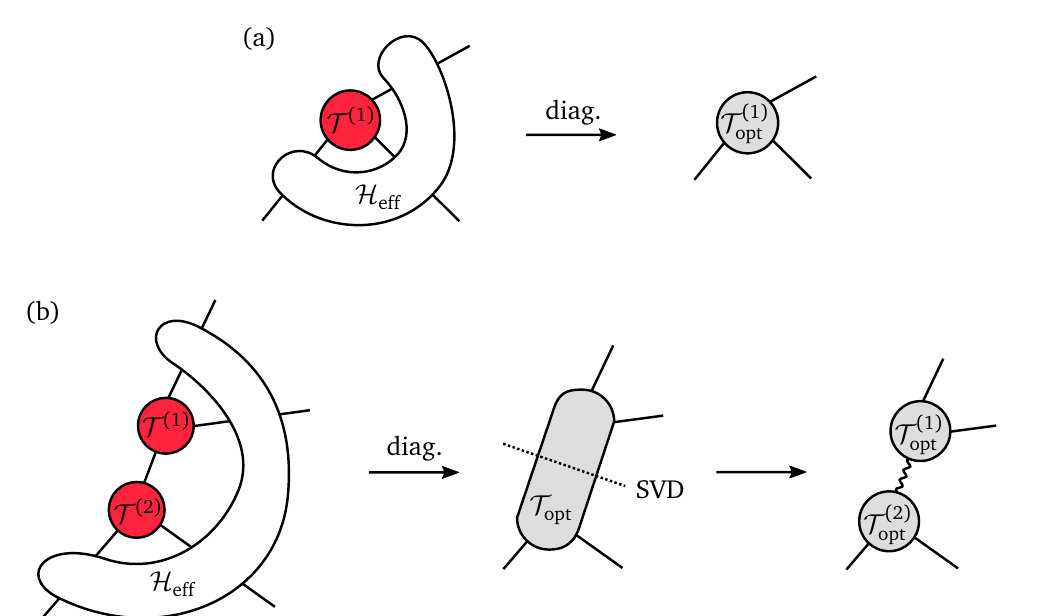
Figure 45: (a) Single-tensor update: the reduced diagonalization problem is formu- lated for one tensor. The optimized tensor is given by the eigenvector of H with eff the smallest eigenvalue. Note that link representations are preserved if H obeys eff some symmetry. (b) Double-tensor update: the reduced diagonalization problem is formulated for two tensors. The number of links of the optimized tensor is given by the number of links on which H acts. Link representations of these links are eff again preserved, in contrast to the one of the link which joins T ( 1 ) and T ( 2 ) : This link results from an SVD and can differ from the original link, if the SVD performs a non-trivial separation of the links of T . Note that if one of the two tensors is a opt two-link tensor, this link separation is trivial and the link created by the SVD will be the same as the external link of the two-link